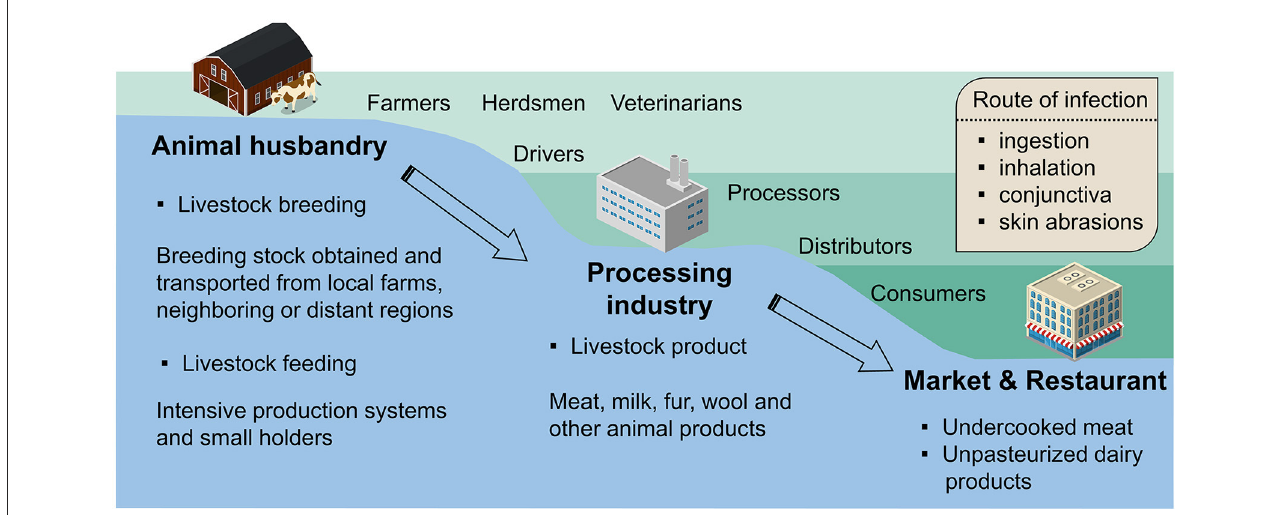
FIGURE1 Conceptual framework for the transmission of human brucellosis. The transmission of pathogens is involved in breeding stock imports, livestock industry chain (black solid arrow), and poorly regulated trades (black dotted arrow).